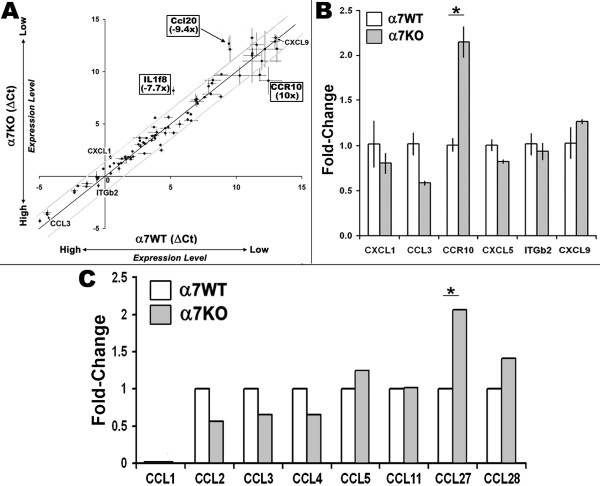
Microarray analysis of infiltrating cells identifies the expression of the chemokine receptor CCR10 to be elevated in the α7KO. A) RNA collected from infiltrating cells from croton oil treated ears was analyzed using SABiosciences arrays. As indicated, the DeltaCt (cycle number to detect transcript after normalization to (β-actin and GAPDH) is inversely related to transcript number. The central line is the linear regression best fit (R2 = 0.95) and flanking dotted lines define the boundaries of statistical significance (p > 0.05). Individual error bars reflect ± the standard deviation. Transcripts that are different in expression between the α7WT and α7KO are boxed and their identity (CCR10, IL1f8 and CCl20) shown. Some additional transcripts that failed statistical significance are also identified. B) RT-PCR analysis (see Methods) of transcripts identified by microarray using Taqman gene expression. There is a good qualitative match with the microarray data. C) A similar analysis of the total ear skin depleted of infiltrating cells revealed no detectable changes in transcript expression that were confirmed by RT-PCR. Analyses for transcripts not on the array such as CCL27 and CCL28 (the ligands for CCR10) present in resident cells of the ear skin were included (* p < 0.01). Neither CCL27 nor CCL28 were detectable in infiltrating cells (not shown).